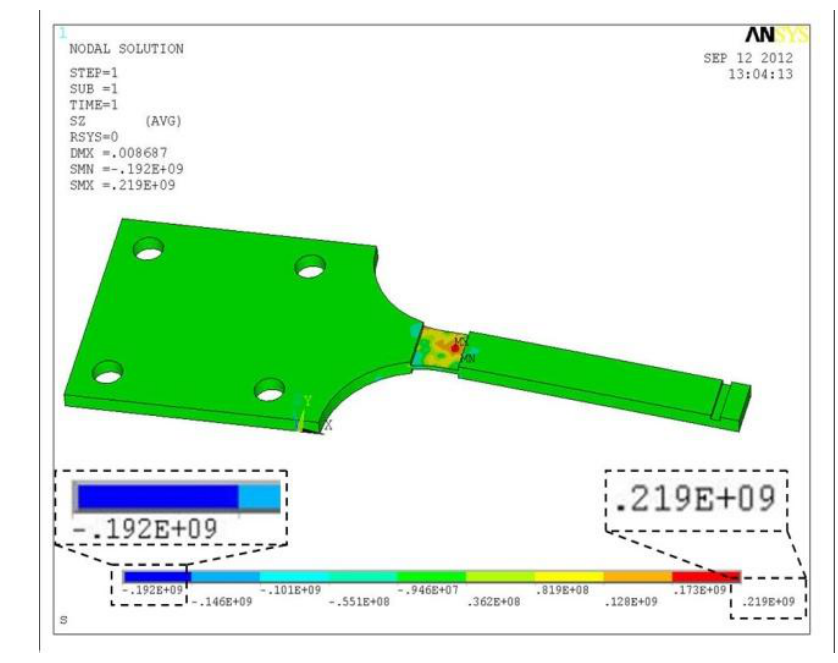
Figure 10. Stress distribution of the